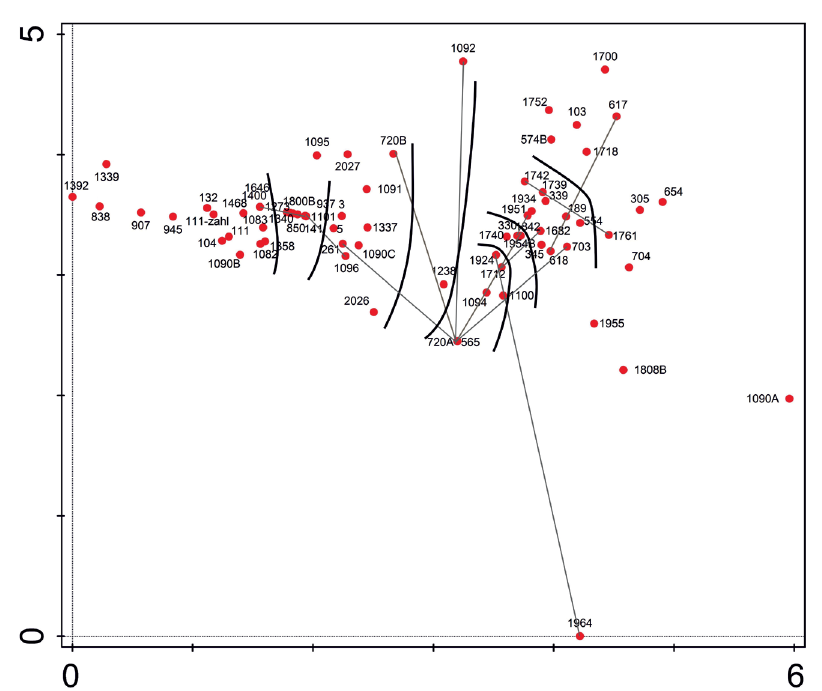
Figure 4. Detrended correspondence analysis of sunken features and their negative spatial relationships (grey line) based on direct overlapping or affinity to construction complexes. Supposed separation of settlement horizons is displayed (black line).